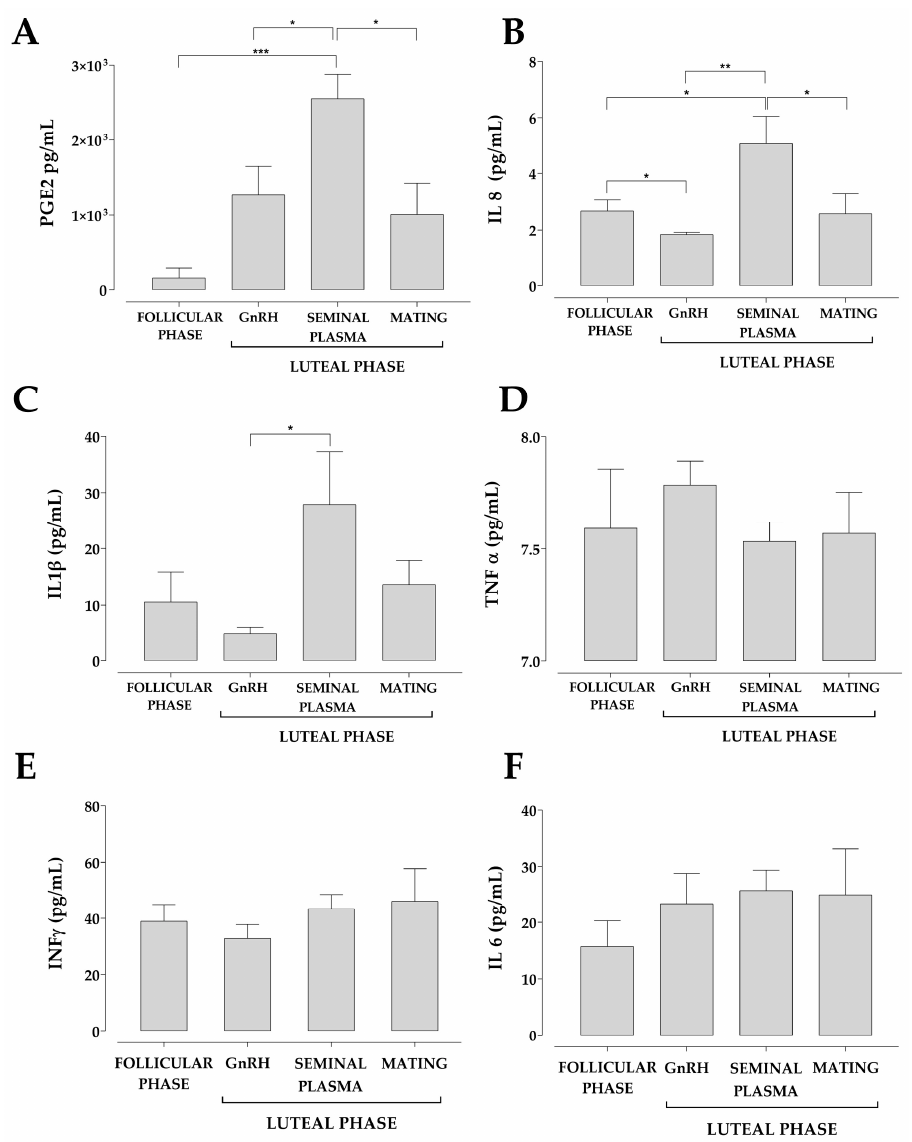
Figure 3. Induction of ovulation with seminal plasma induced an increase in PGE2, IL-8 and IL-1 β concentration in the uterine fluid of llamas. Representative bar graph of the concentration of PGE2 ( A ), IL-8 ( B ), IL-1 β ( C ), TNF- α ( D ), INF γ ( E ) and IL-6 ( F ). Concentration of inflammatory markers were measured using ELISA test in triplicate. Each bar represents the mean ± SEM of at least five independent experiments. * p < 0.05; ** p < 0.01; *** p < 0.001. Concentration of PGE2, IL-8, IL-1 β , IFN γ and IL-6 in the uterine fluid between left and right horns did differ among experimental groups but it did not change within the same group (Figure 4A–E).